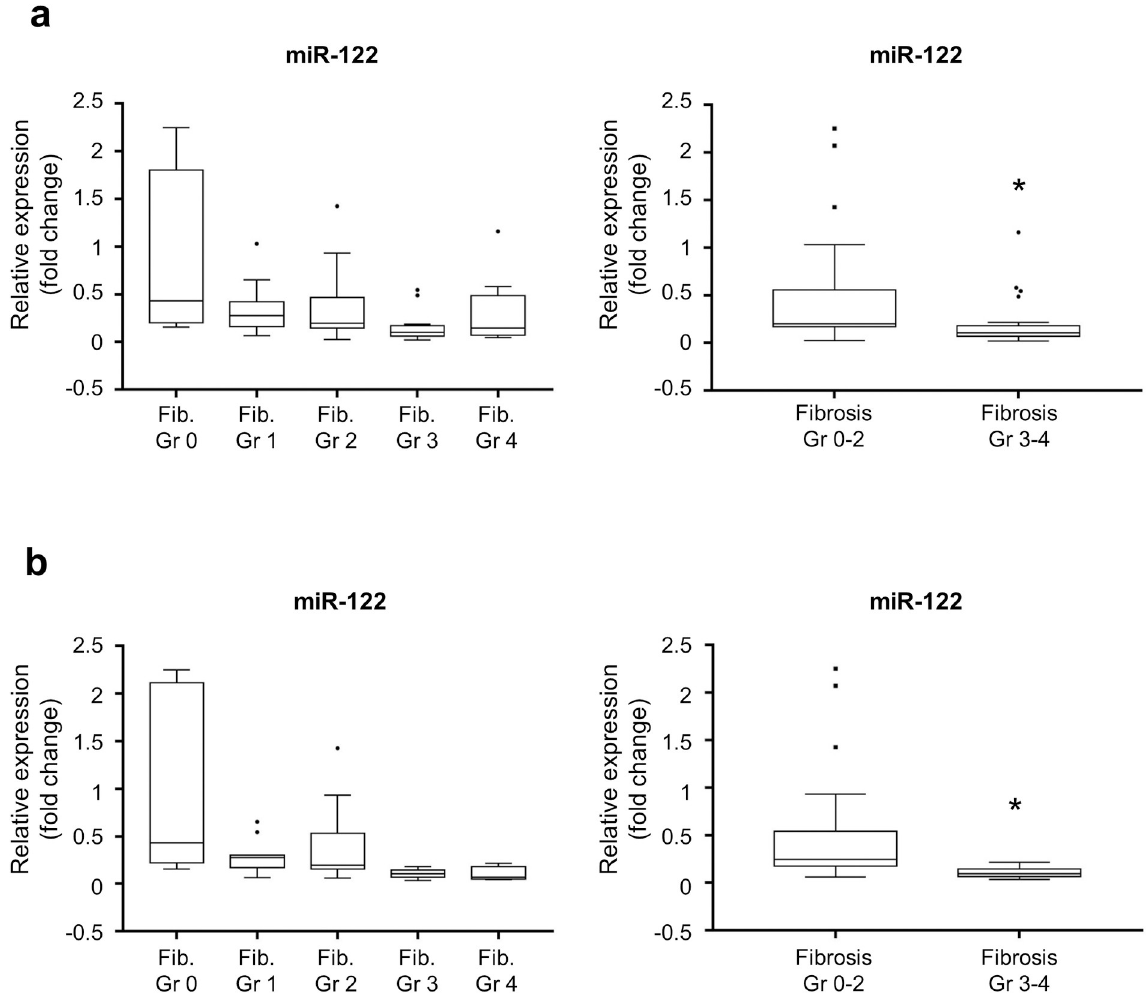
Fig 3. The expression of miR-122 is downregulated in advanced liver fibrosis stages. miR-122 expression was quantified in (a) total population and (b) non-viral etiological population. � : p <